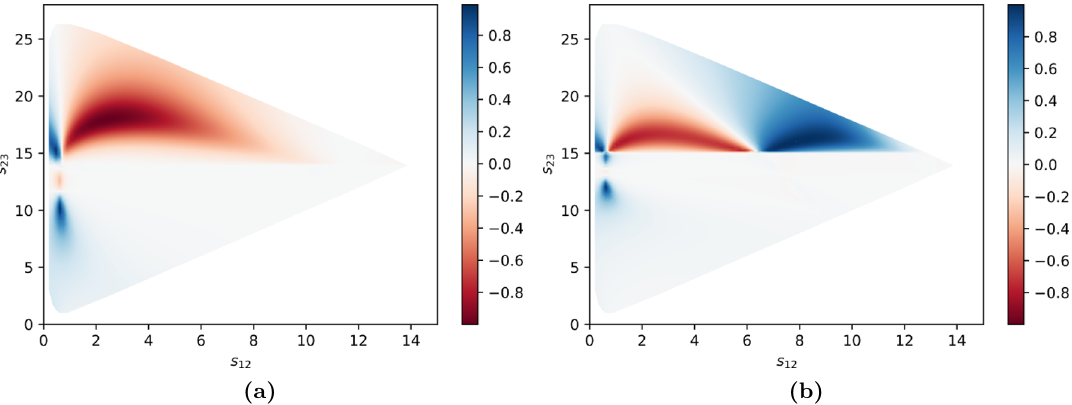
Figure 4. CP distributions from interference of a (cid:26) resonances and the resummed propagator T R